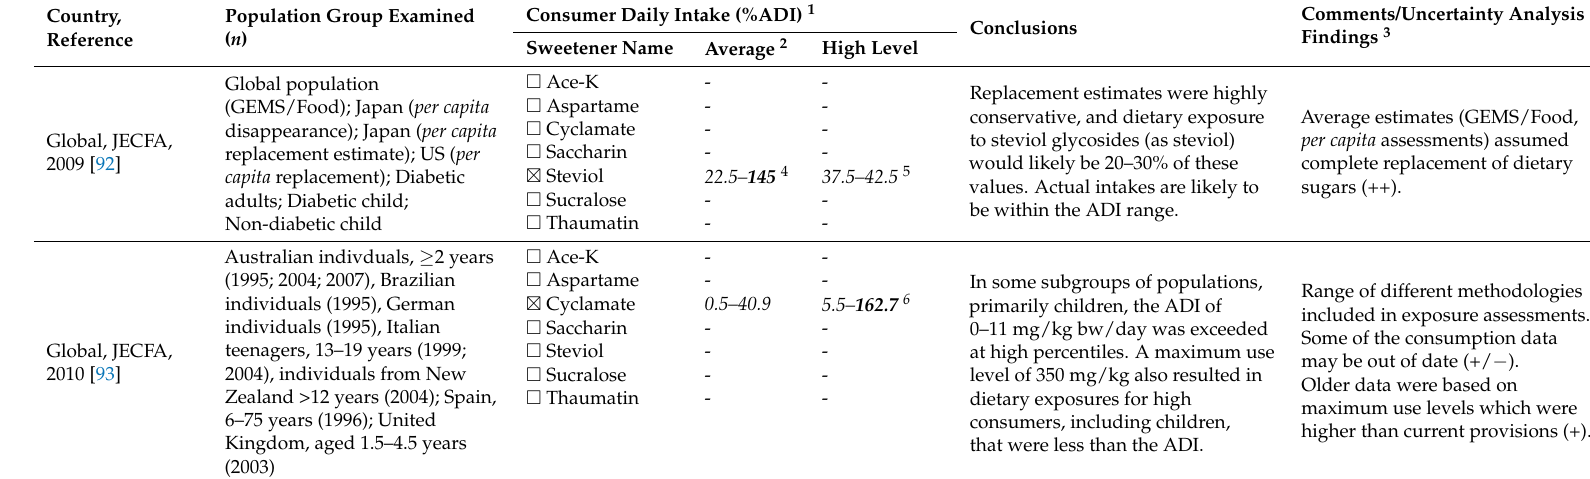
Table 5. Estimated Daily Intakes for Low-/No-Calorie Sweeteners Evaluated or Derived by